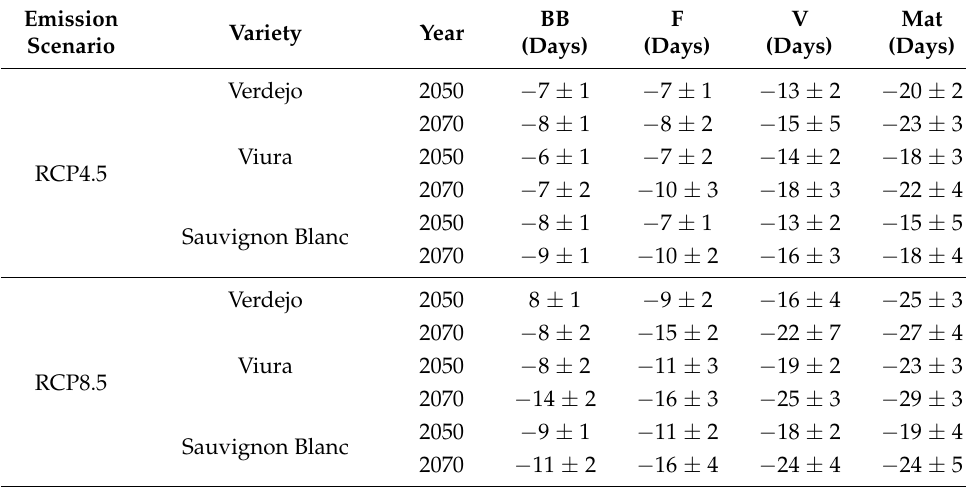
Table 4. Projected advance (in days) of each phenological stage for each variety for RCP4.5 and RCP8.5 scenarios by 2050 and 2070 (BB: budbreak; F: flowering; V: v é raison; Mat: ripening